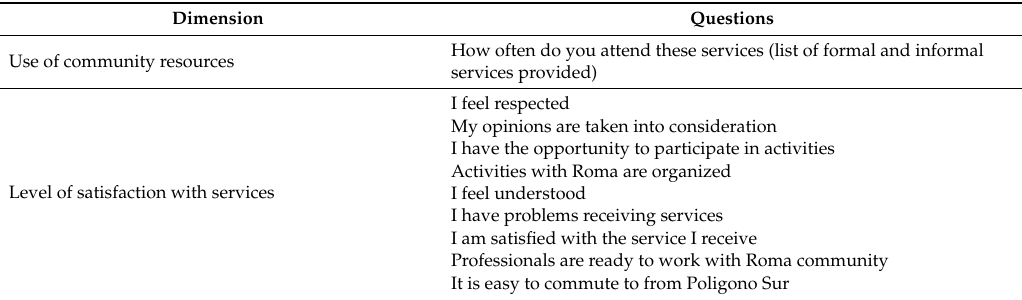
Table A1. Roma neighbor survey for resource identification and